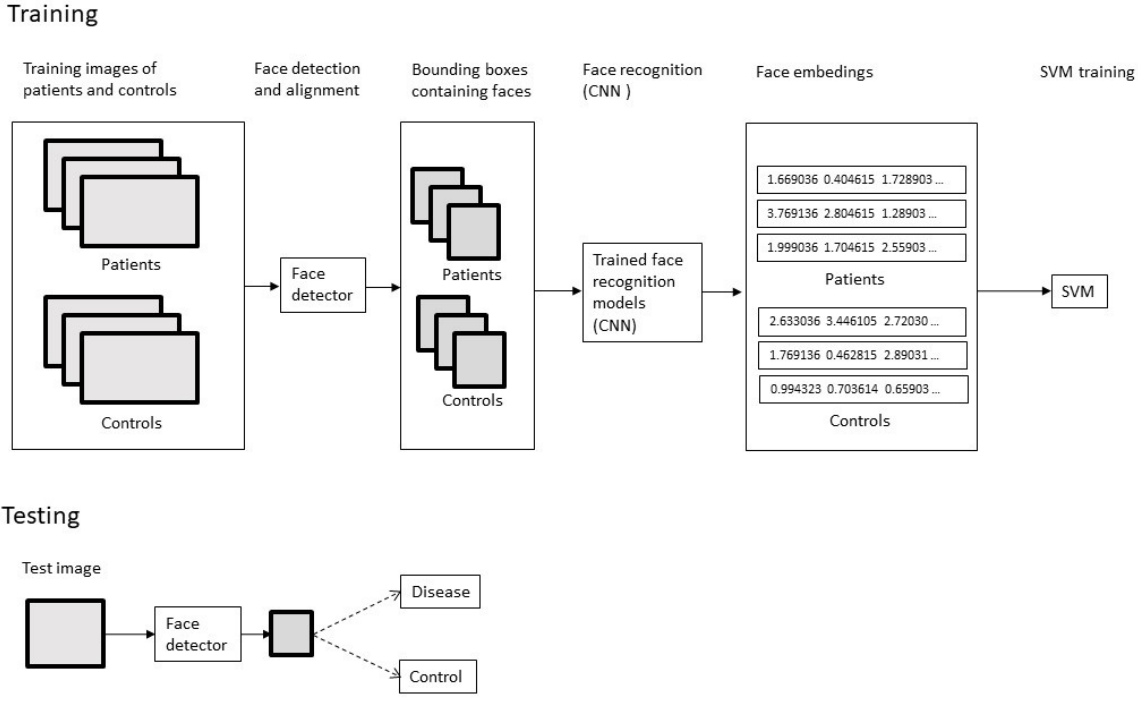
Figure 1. Diagram of the system architecture .